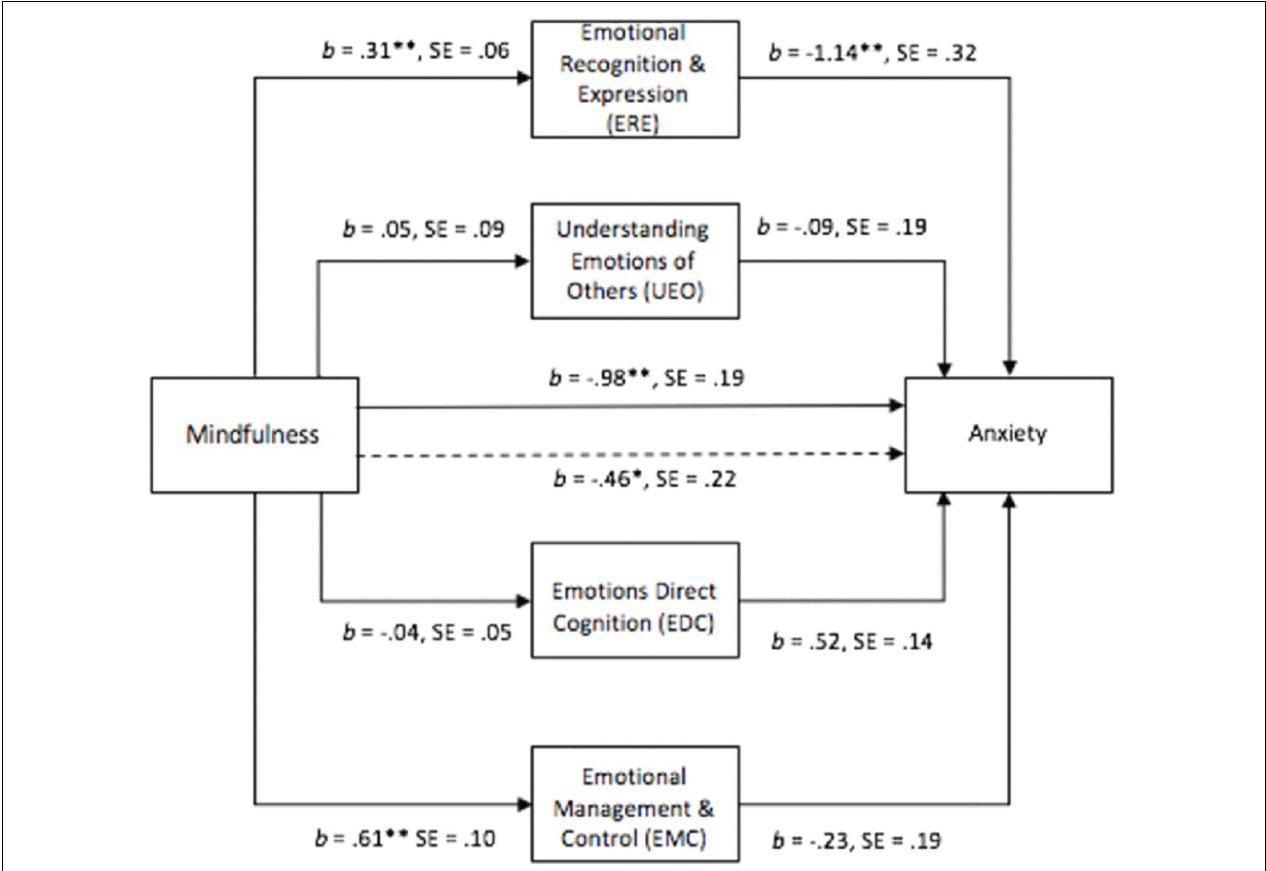
FIGURE 2 | Multiple mediator model examining relation between dispositional mindfulness, subscales of El and anxiety. ∗ p < 0.05; ∗∗ p <